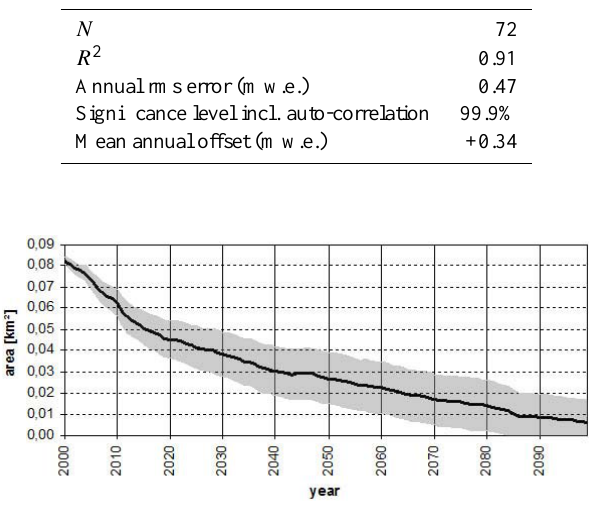
Fig. 7. Evolution of the surface area of Martial Este Glacier 2000– 2099.